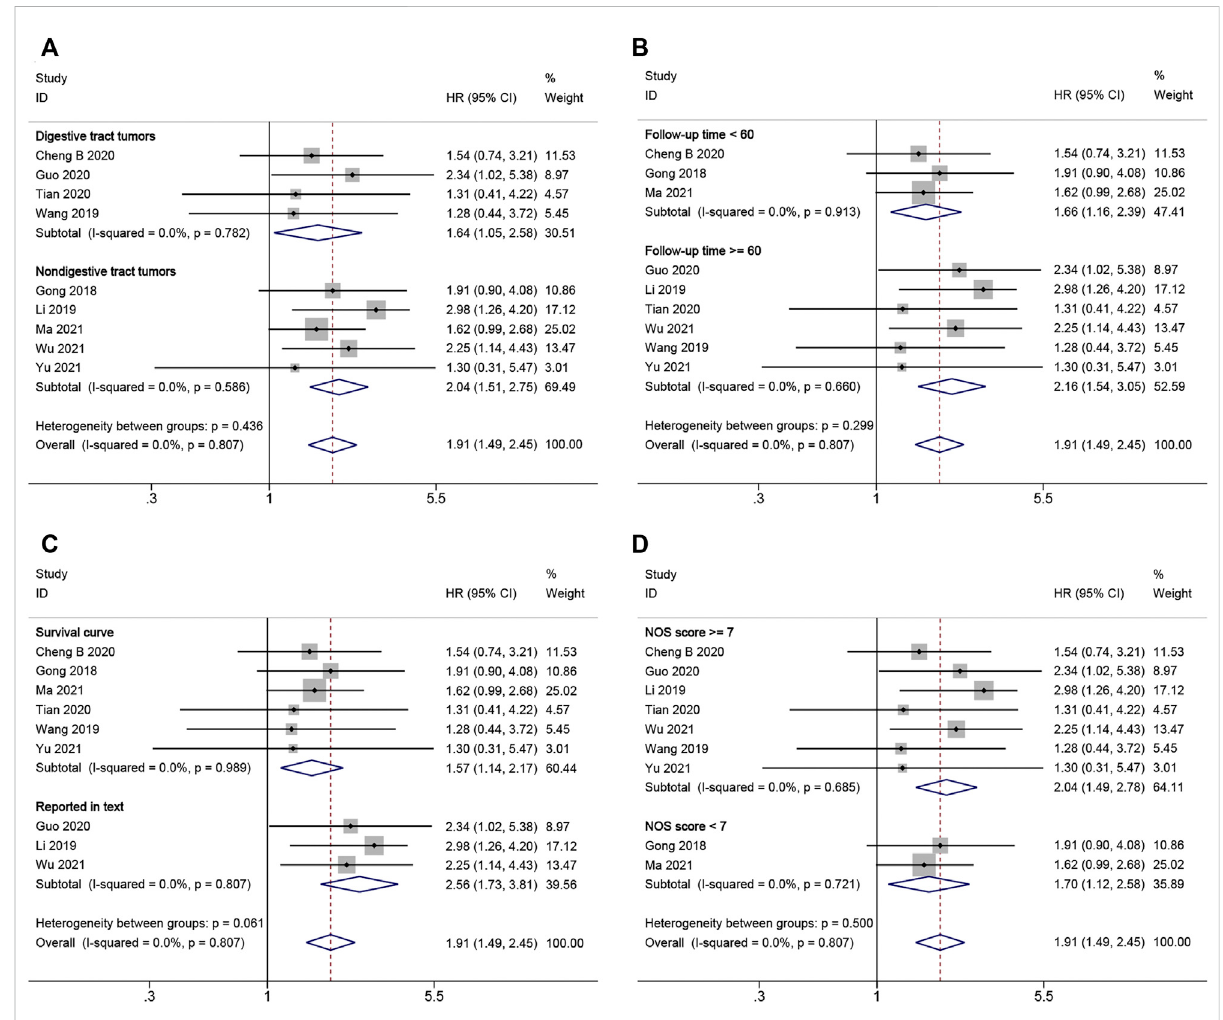
FIGURE 3 Forest plots for subgroup analysis of LINC00662 expression with overall survival. (A) Subgroup analysis strati fi ed by cancer type. (B) Subgroup analysis strati fi ed by follow-up time. (C) Subgroup analysis strati fi ed by HR availability. (D) Subgroup analysis strati fi ed by NOS